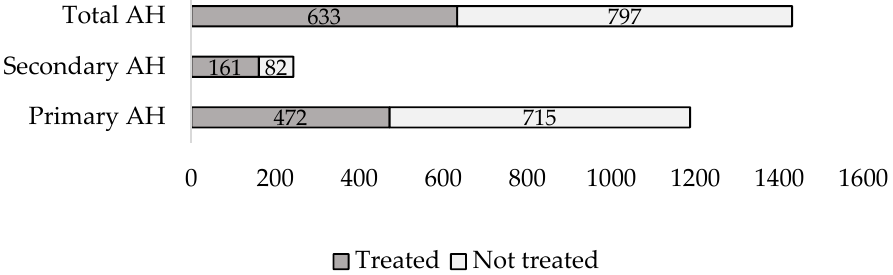
Figure 1. Number of patients diagnosed with AH and number of patients treated with pharmacological therapy by the etiology of AH.